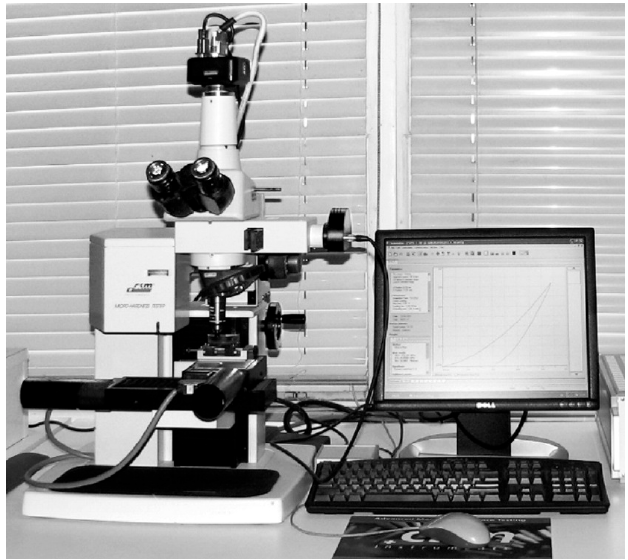
Figure 1. Microhardness tester (CMS Instruments) with image analysis processing LUCIA D [39].